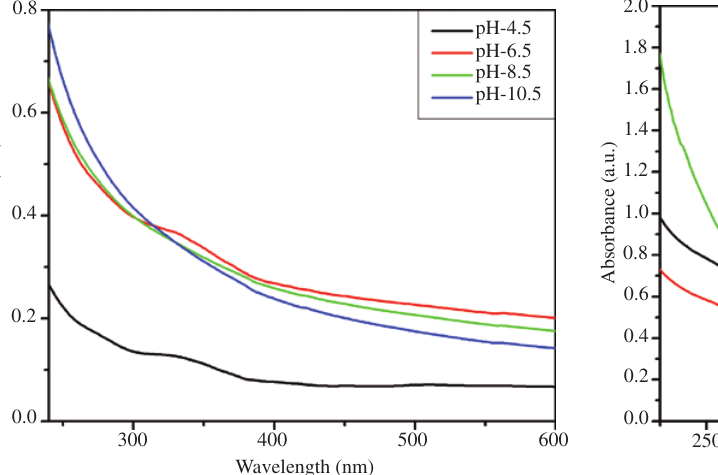
Figure 4: Effect of Chlamydomonas reinhardtii cell free extract con- centration on the synthesis of zinc sulfide